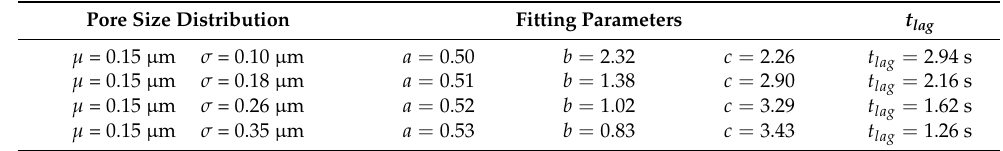
Table 4. Fitting parameters of the breakthrough curves in Figure 4b.